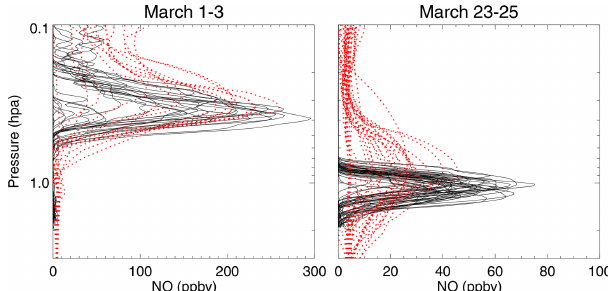
Figure 9. Comparison of nitric oxide data recorded by SOFIE (solid black curves) and ACE (dotted, red) for the two 3d periods indi- cated. For 1–3 March, both instruments are observing near 81 ◦ N; for 23–25 March, SOFIE is observing near 88 ◦ N and ACE is ob- serving in the range 68–72 ◦ N. The consequences of SOFIE and ACE observing at these different latitudes for the second date range are discussed in the text. Figure 10. Comparison of WACCMX NO (dashed curve), ACE